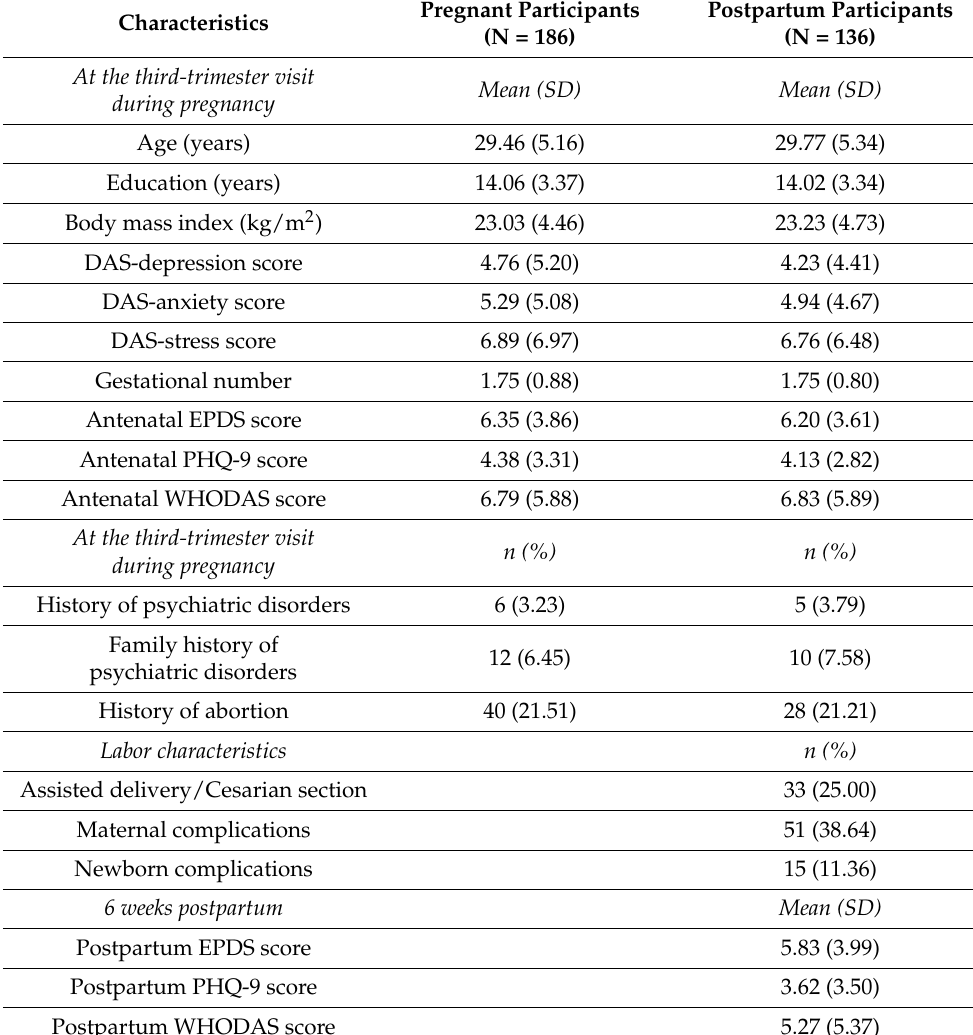
Table 1. Characteristics and psychopathology of 186 pregnant and 136 postpartum